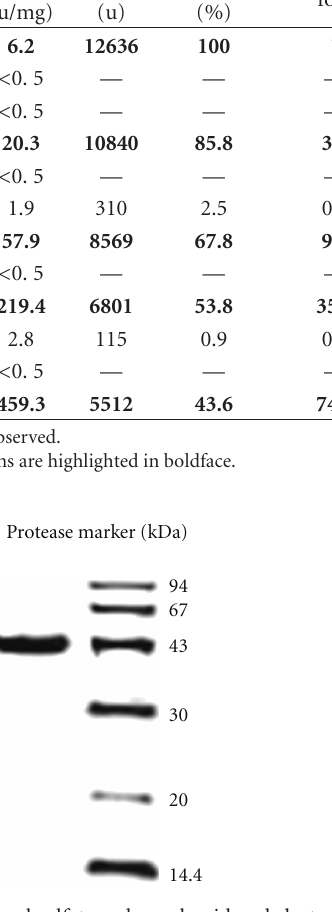
Figure 3: Sodium dodecyl sulfate-polyacrylamide gel electrophore- sis results. Left lane: purified protease (fraction SU2, 10 μ g). Right lane: molecular mass markers, from top downward: phosphorylase b (94kDa), bovine serum albumin (67kDa), ovalbumin (43kDa), carbonic anhydrase (30kDa), and α -lactalbumin (14.4kDa). (Figure 5). At a protease concentration of 1 μ M, 5 μ M, 15 μ M,